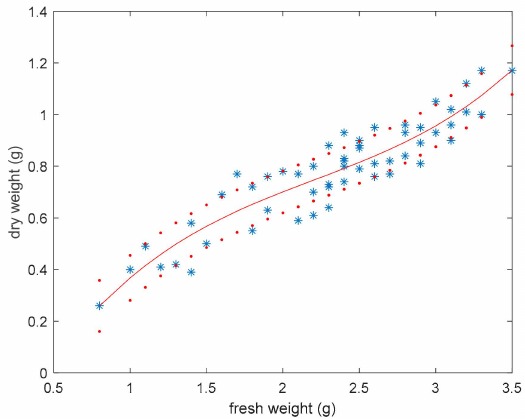
Figure 7. Fresh weight vs. dry weight in Pennatula rubra ; the red curve is the polynomial interpolation of the third order, and red dot curves include 95% of